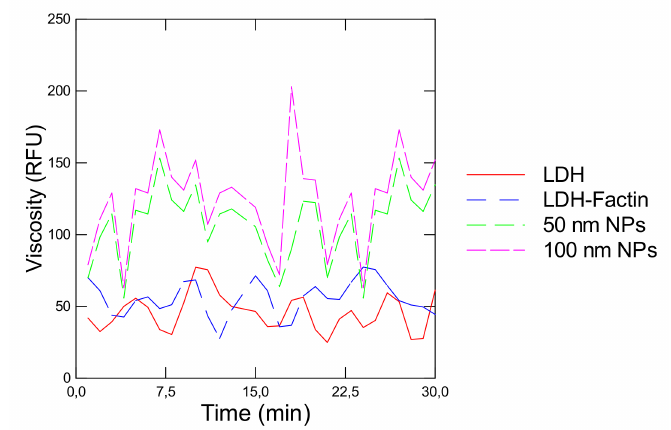
Figure 2. Change in viscosity by F-actin and NPs during the LDH reaction. The viscosity